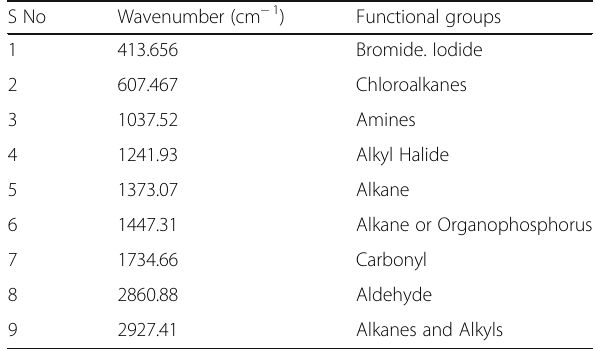
Table 1 Wave number and the corresponding possible functional groups present in the